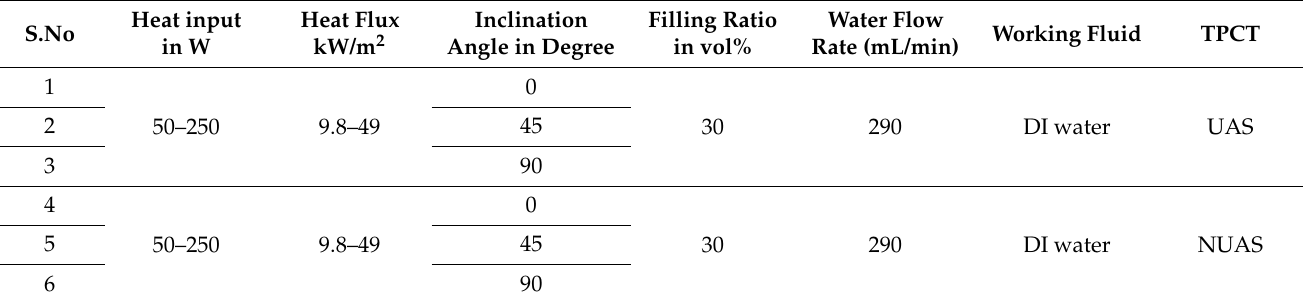
Table 1. Experimental parameter